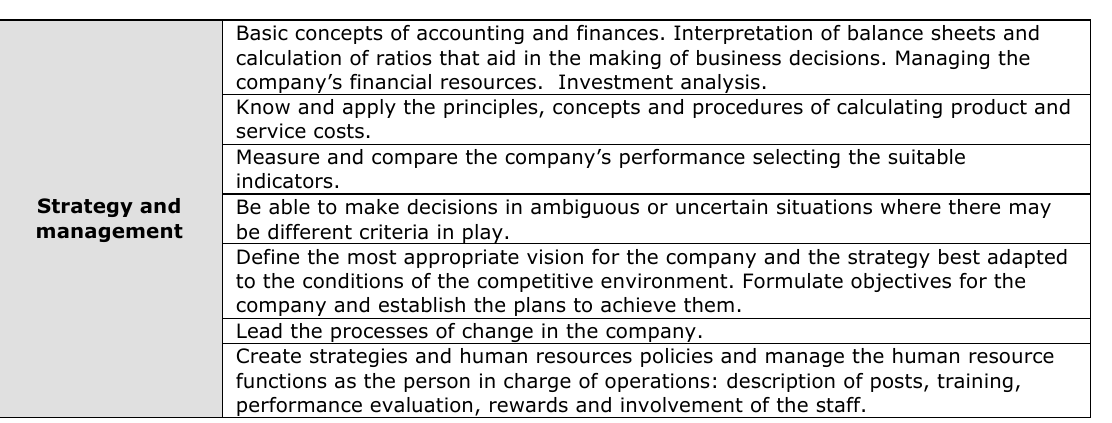
Table 2a. “Specific competences of Industrial Engineering”.